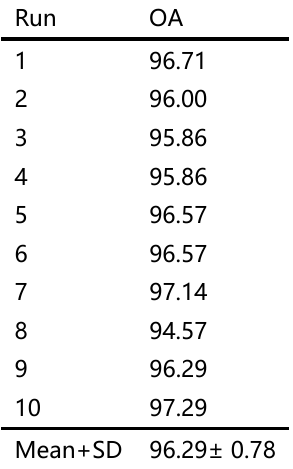
Table 2. Statistical analysis on the overall